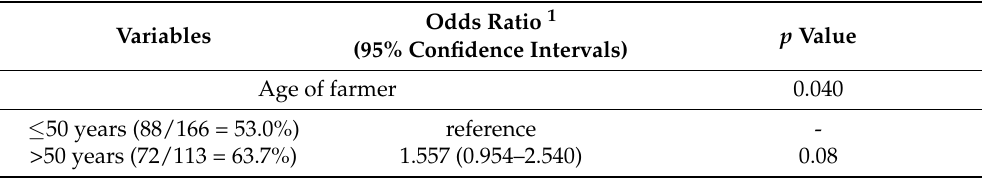
Table 6. The results of the multivariable analysis for a high proportion (>29%) of H. contortus among Trichostrongylidae helminths in faecal samples from 279 sheep flocks in a countrywide investigation in Greece.